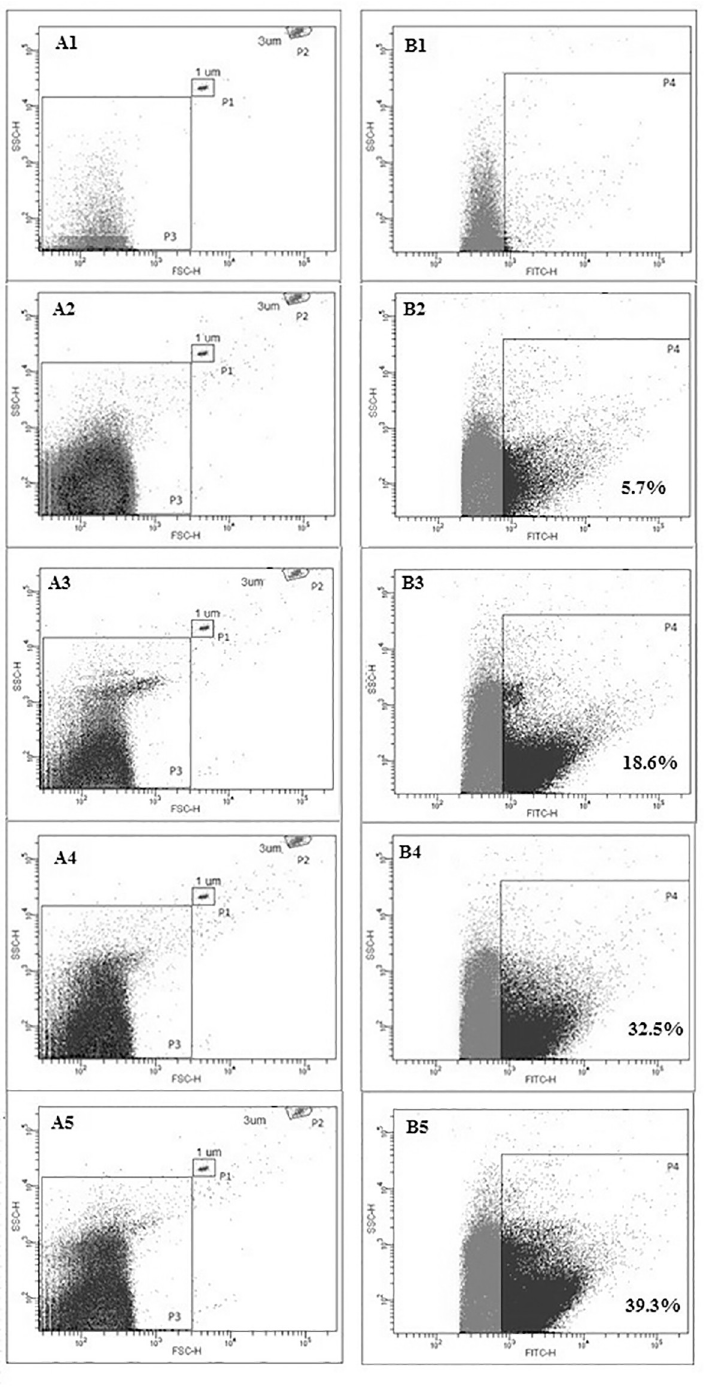
Fig 2. Analysis and counting of MPs of different cellular origins by flow cytometry on a FACS Canto II. The noise threshold was set up in the FITC fluorescence channel (200 a.u) (B1-B5). A1, B1 –filtered HBS buffer without MPs (negative control); A2, B2 –MPs from erythrocytes; A3, B3 –MPs from platelets; A4, B4 –MPs from THP-1 cells; A5, B5 –MPs from ECs. Annexin V-FITC was added to all probes. All events above the FITC fluorescence threshold (200 a. u) were counted in the SSC/FSC window (A1-A5) in the size gate < 1 μ m (gate P3). After subtracting the events in the negative control, all events in this gate were considered MPs. Gate P1 (A1-A5)–size calibration beads (1 μ m), gate P2 (A1-A5)–counting beads (3 μ m). Gate P4 (B1-B5) annexin V-positive events above the threshold set up in the